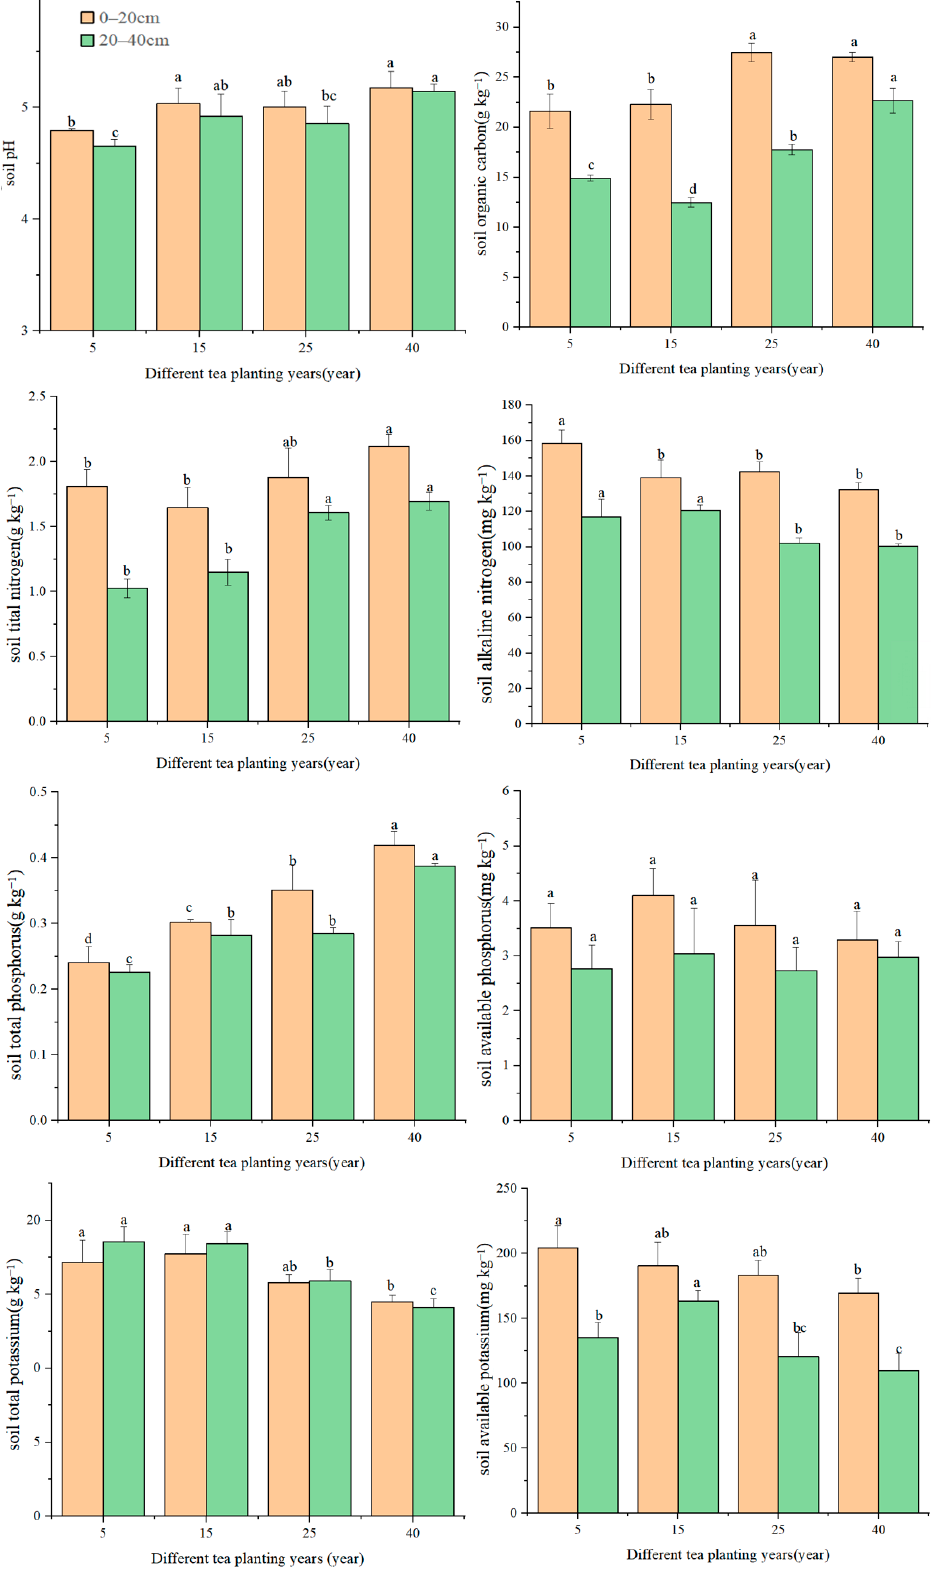
Figure 1. Nutrient characteristics of soil under different tea-planting years. Different lowercase letters under the same soil layer represent that the data in different planting years are significantly different ( p < 0.05).